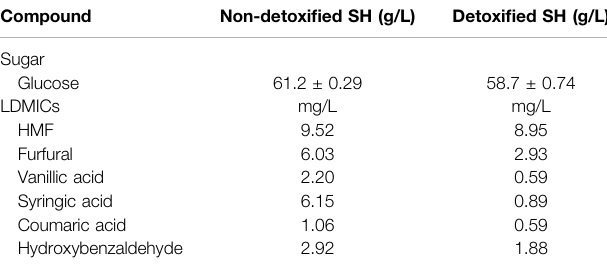
TABLE 2 | Concentrations of glucose and LDMICs in detoxi fi ed and non- detoxi fi ed SH. Standard deviation for glucose reading represents